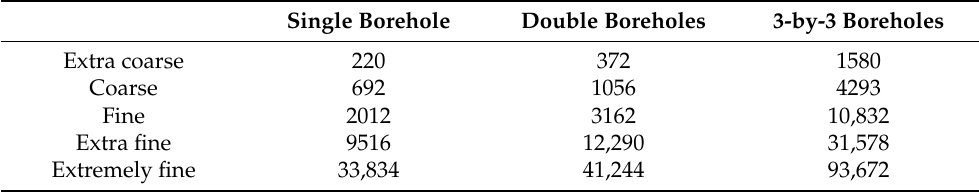
Table A1. Number of mesh elements for various borehole arrangements and mesh